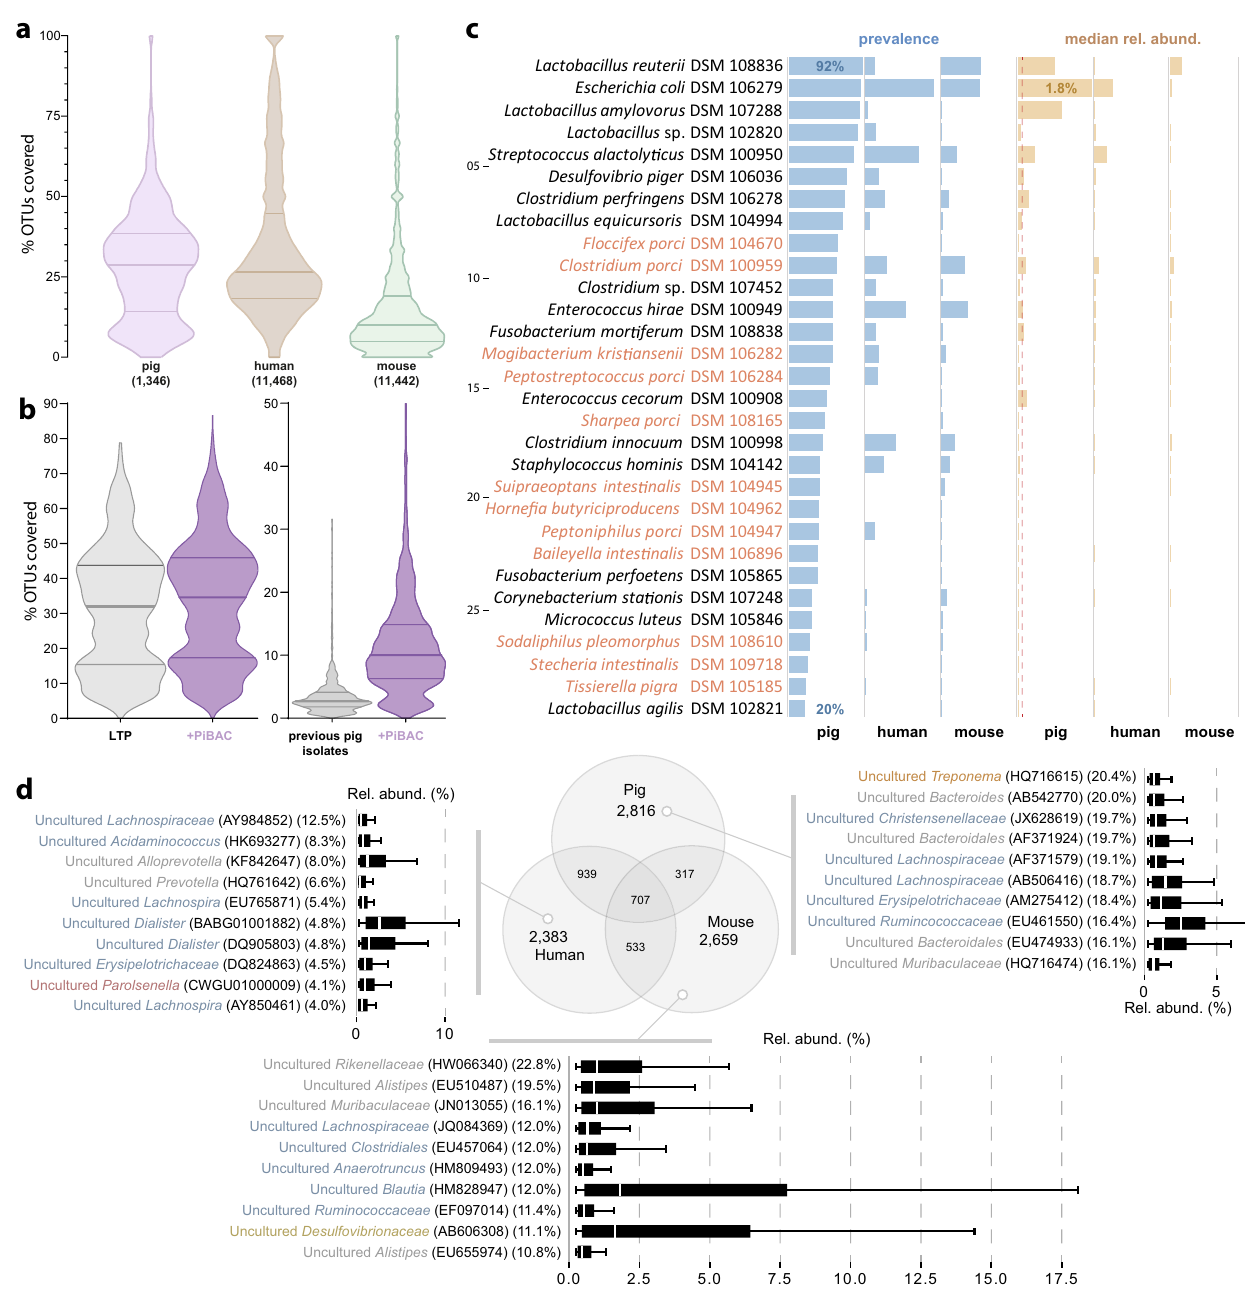
Fig. 4 Host-speci fi city revealed by meta-analyses of 16S rRNA amplicons. a Percentage of IMNGS-derived 47 16S rRNA amplicon reads from the pig, mouse, and human intestine (numbers of samples analysed indicated in brackets) covered by sequences from all isolates. Horizontal lines indicate the median (middle), 25% (bottom), and 75% (top) quantiles. b Coverage of the 1346 pig gut samples by the 16S rRNA gene sequences from 13,903 isolates available via the Living Tree Project (LTP) 48 or from 31 strains isolated from the pig intestine and available from strain collections prior to the present work with (violet) or without (grey) addition of the 38 novel taxa in PiBAC. c List of the 30 isolates with signi fi cantly increased prevalence and relative abundances in the pig intestine. The number of samples considered were as in a . Novel taxa are written in orange letters. The dashed line indicates 0.1% median relative abundance. d Overlap of 16S rRNA amplicon-based molecular species between the three host species (pig, human, mouse). The number of samples considered are as in a . The Venn diagram shows OTU numbers common between or unique to the respective host. The box plots display the relative abundance of the respective top-10 prevalent, host-speci fi c OTUs (their prevalence is in brackets; coloured according to phyla as in Fig. 1). The box plots indicate the median (middle line), 25% and 75% quantiles (bottom and top line, respectively), and 1.5 × inter-quantile range after Tukey. For analyses in c and d , mouse and human data were randomly sub-sampled to obtain a number comparable to pigs ( n = 1346